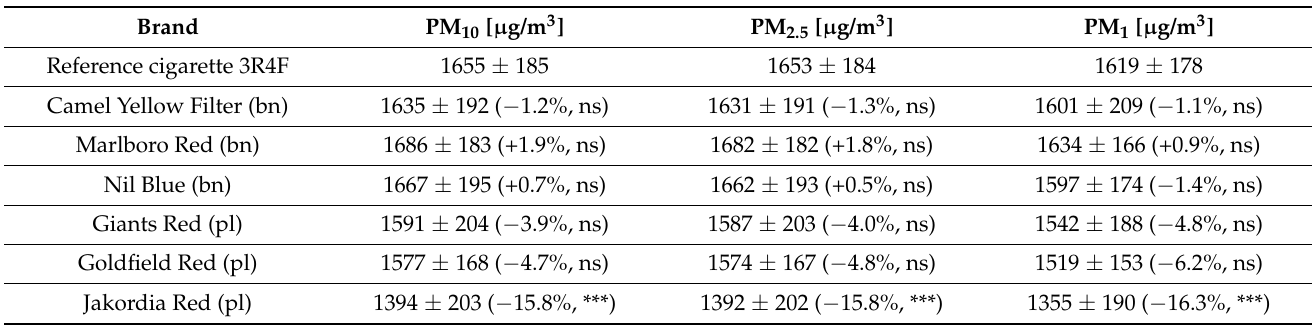
Table 2. Mean Concentrations (C mean ) of PM 10 , PM 2.5 , and PM 1 with standard deviation (SD) of all cigarettes investigated. Percentage variations of C mean of the brand-name (bn) and private-label (pl) cigarettes to C mean of the reference cigarette 3R4F are given in brackets. ns = Not significant ( p ≥ 0.05). *** = Very significant ( p <